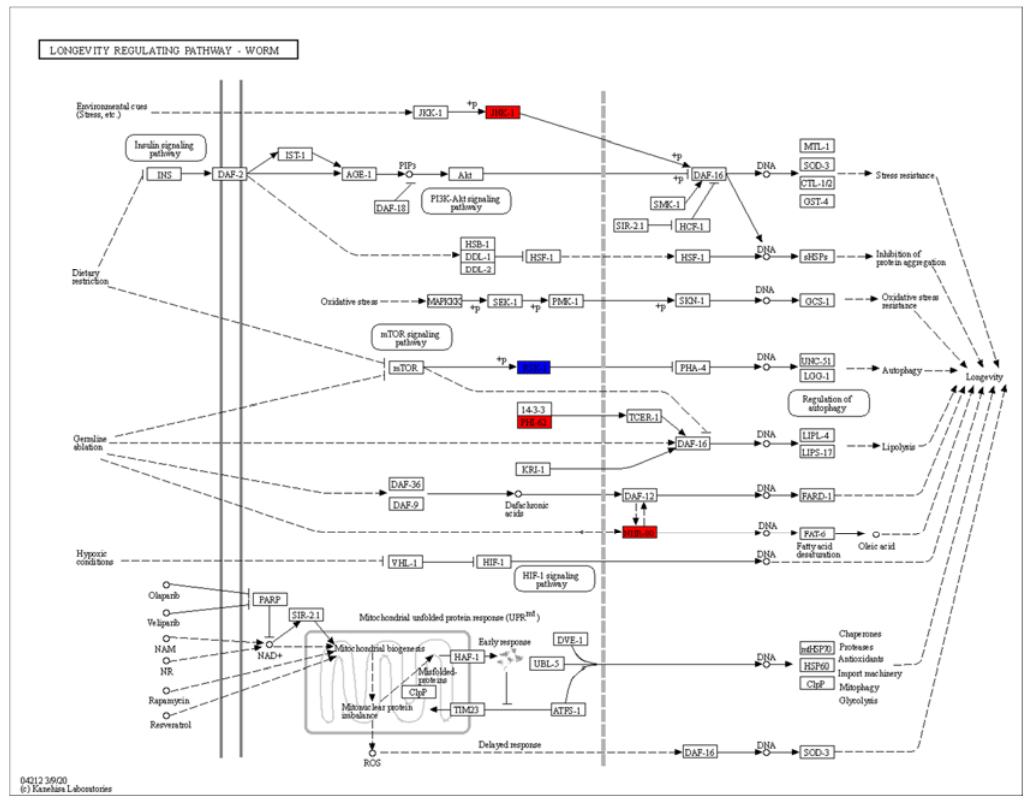
Figure 7. The KEGG analysis of differentially regulated genes.